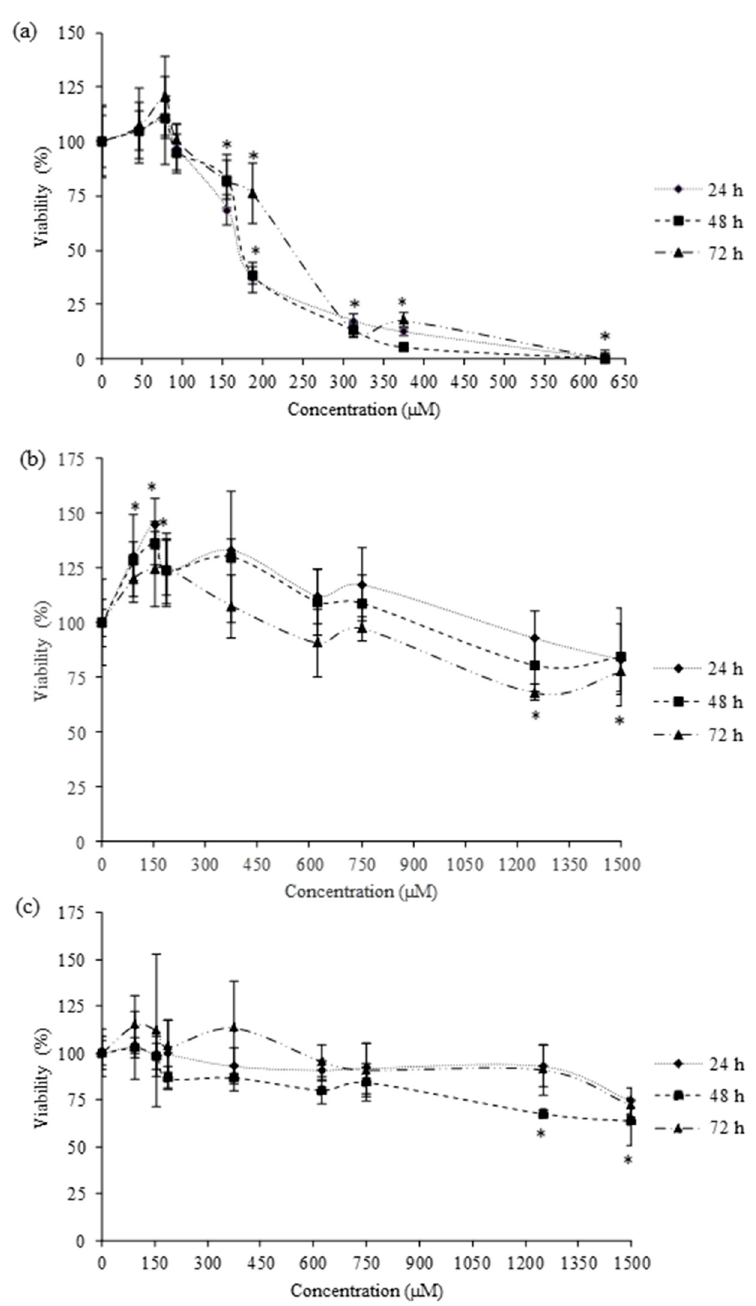
Figure 2. Cell viability of ( a ) amitraz, ( b ) 2,4-DMF, and ( c ) 2,4-DMA on HepG2 cells by MTT assay after 24, 48, and 72 h of exposure. Results are expressed as mean ± SEM (n = 3). (*) p ≤ 0.05 indicates significantly differences from control.